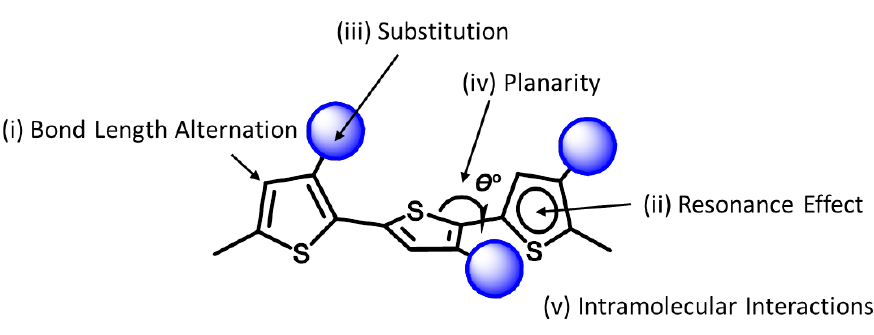
Figure 5. Structural factors determining the band gap of